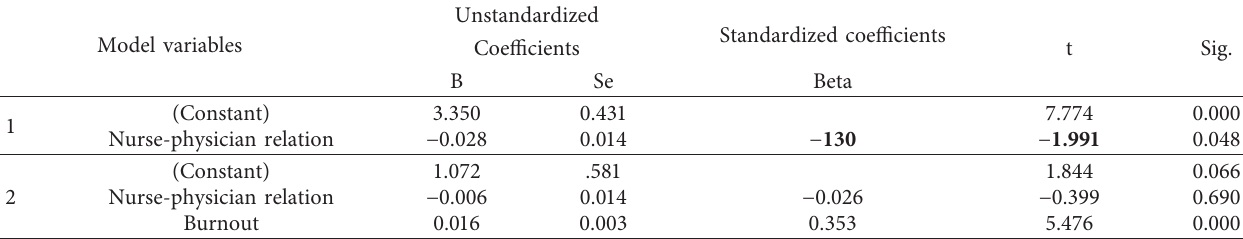
Table 2: Mediation effects of burnout on the relationship between Nurse-Physician Relation and Turnover Intention.